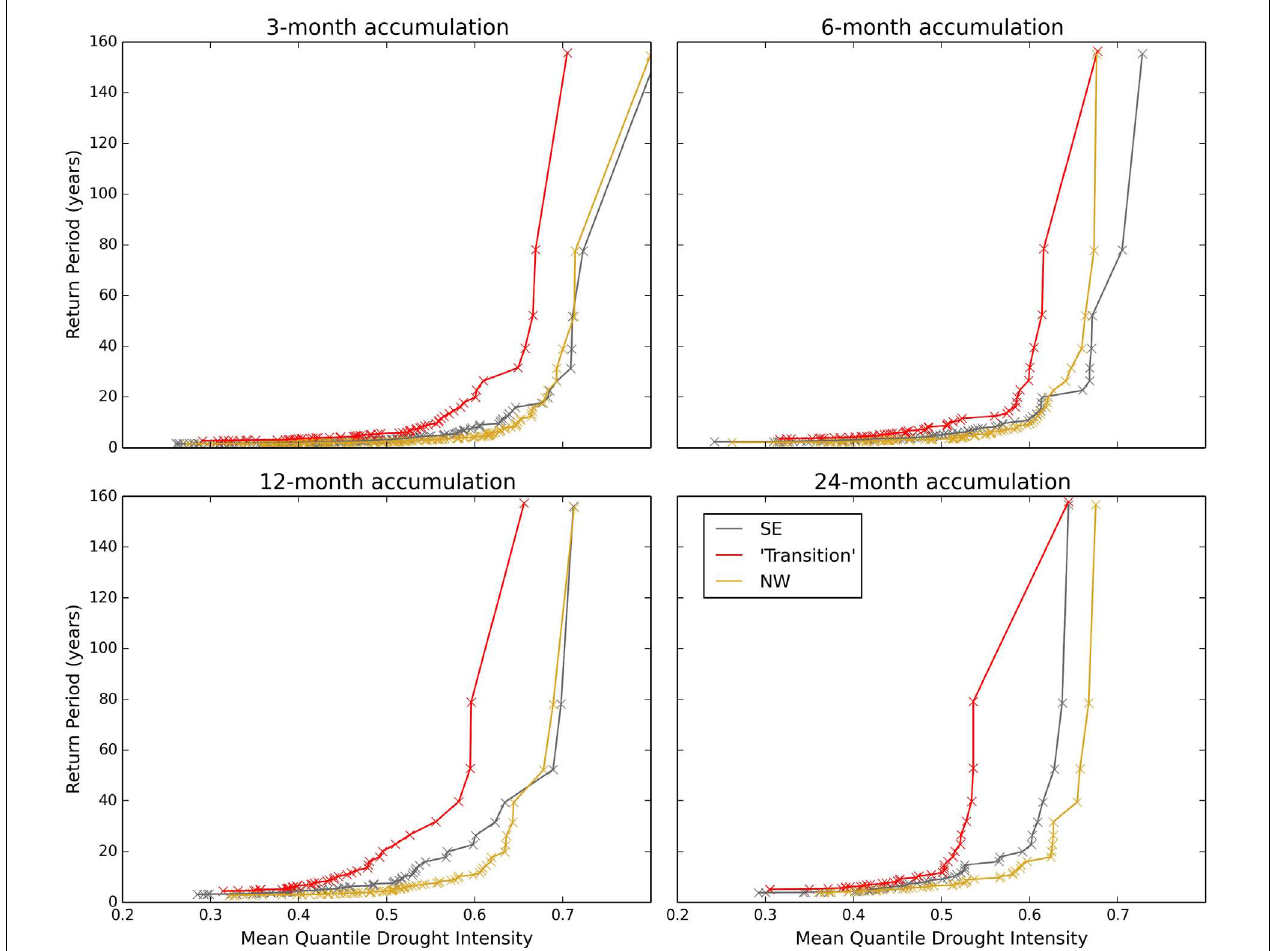
FIGURE 5 | Return period of drought events calculated based on their mean quantile drought intensity ( q int ) for the three regions of GB, and for different accumulation period of precipitation (3, 6, 12, and 24